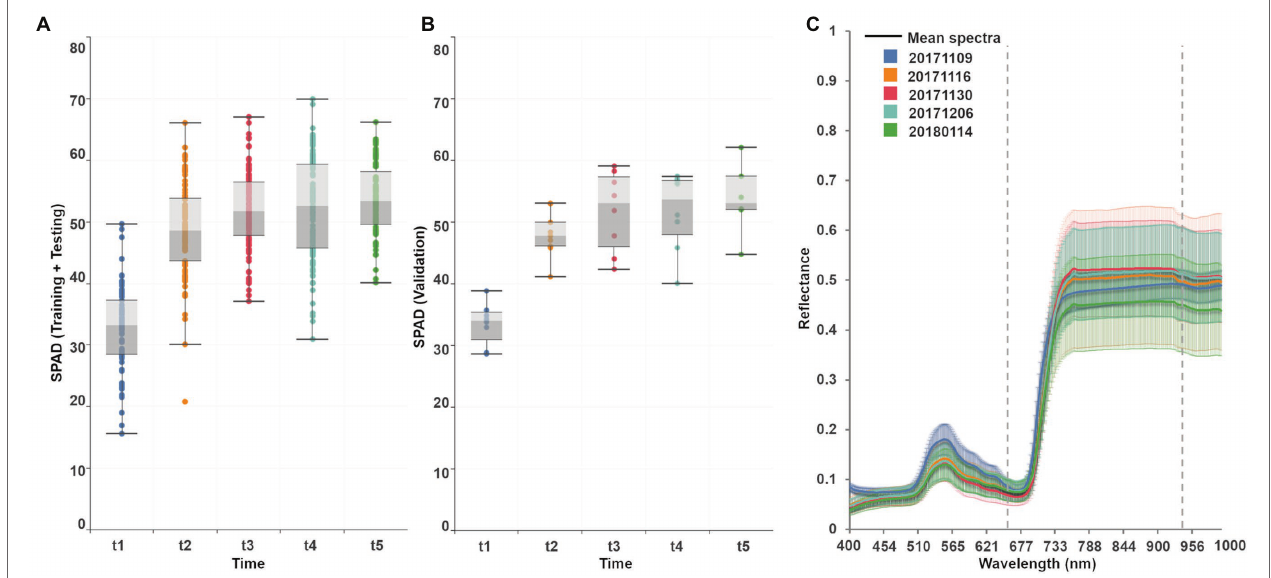
FIGURE 4 | (A) Traditional boxplots show the multi-temporal distribution of SPAD observations divided into training/testing (left) and validation sets (right). Median values are shown as the horizontal lines near the box centers, and the quartiles are delimited by the horizontal lines above and below the median. Whiskers indicate the variability outside upper and lower quartiles, locating the maximum and minimum scores at the top and bottom ends, respectively. An outlier observation (21 SPAD units) is shown during the second campaign ( t 2 ) in the training/testing dataset. (B) Reflectance profiles collected per field campaign (format YYYYMMDD). The continuous lines indicate the mean spectra, and the filled areas define the range of reflectance measured each time. Dashed lines indicate the wavelengths where reflectance data reaches the lowest (~650 nm) and the highest (~950 nm)